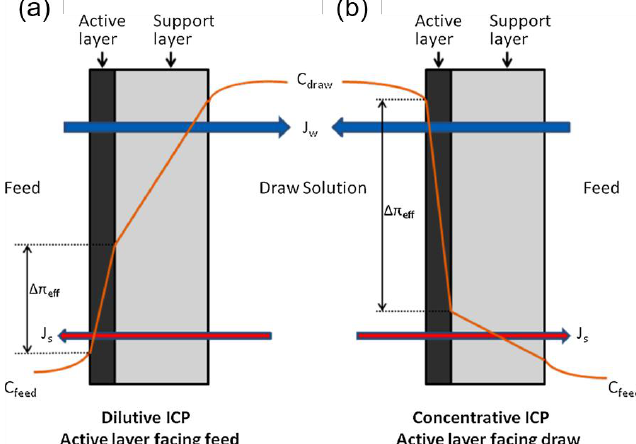
Figure 3. Illustration of both internal concentration polarisation (ICP) and external concentration polarisation (ECP) through an asymmetric FO membrane in ( a ) active layer facing the feed solution (AL-FS) and ( b ) active layer facing the draw solution (AL-DS) orientations. ICP occurs within the membrane support layer, and ECP exists at the surface of the membrane active layer. C feed , C draw , ∆𝜋 𝑒𝑓𝑓 , J s and J w represent the feed solution concentration, draw solution concentration, effective driving force, reverse salt flux and water flux, respectively. Reprinted from [40] with permission from Elsevier.